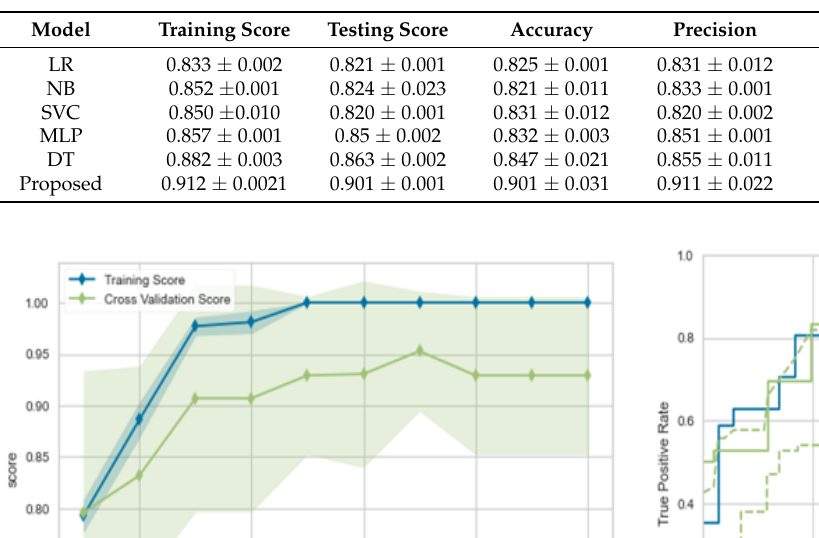
Table 3. Results of the prognosis model after 3 months.